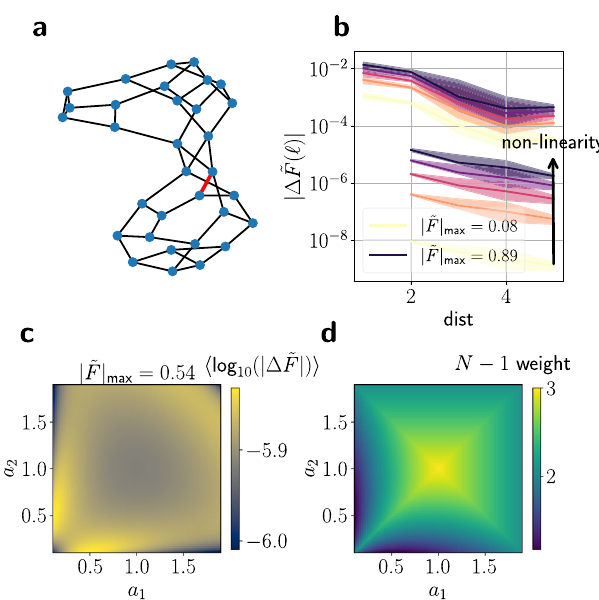
Fig. 5 Robust design of network isolators in the Kuramoto model. a To study the effect of non-linearity on network isolators, we simulate the failure of a single link (red) in a network consisting of two modules that are connected via a network isolator. b We consider the median absolute non-linear fl ow changes j Δ ~ F ð ‘ Þj (Eq. (11)) on a link ℓ after the removal of the link shown in ( a ). We analyse the effect of edge distance to the failing link ( x -axis) and increasing degree of non-linearity (colour code from light to dark). We compare the fl ow changes in the lower module that contains the failing link (curves on the upper left) and the isolated module (curves on the lower right) by averaging the fl ow changes over all links in the given module at a fi xed distance. As expected, fl ow changes in the upper module are lowest for a weakly non-linear system (bright line) and increase with the non-linearity, but a strong isolation effect persists even for a high degree of non-linearity (dark purple line). Shaded region indicates the 0.25- and 0.75-quantiles evaluated over the given distance. c We fi x the overall available edge weight of the four edges forming the isolator to ∑ a = 4 and systematically scan over the remaining degrees of freedom, i i measuring the isolator performance in terms of the mean logarithmic fl ow changes h log 10 ðj Δ ~ F jÞi for a fi xed degree of (intermediate) non-linearity. We observe that a heterogeneous isolator where the weights differ strongly provides the best shielding. d We evaluate the available worst-case N − 1 weight, i.e. the overall edge weight connecting the two modules after the failure of a single link in the isolator, for the same set of edge weights as in ( c ). Here, isolators with homogeneous weights perform best. Edge weights of all non- isolator edges are set to unity, A ij = 1, 8ð i ; j Þ 2 E ( G ) in all panels.